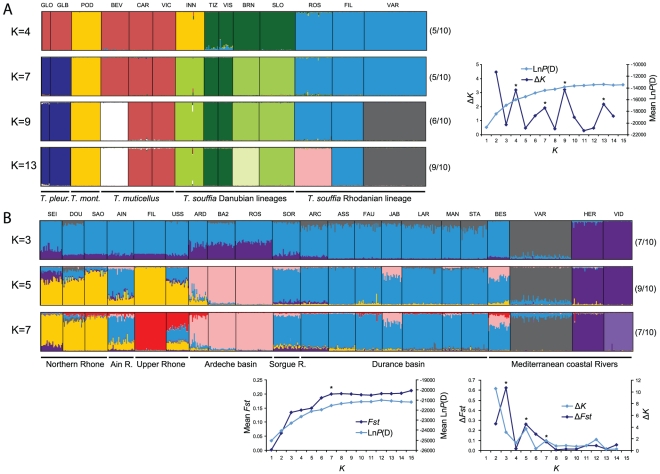
Phylogenetic and multivariate analyses of microsatellites data.Unrooted Maximum Likelihood tree based on microsatellites Dc distances (A) and FCA scatter plots for T. s. souffia population samples (B) and population samples representative of Telestes genus (C).